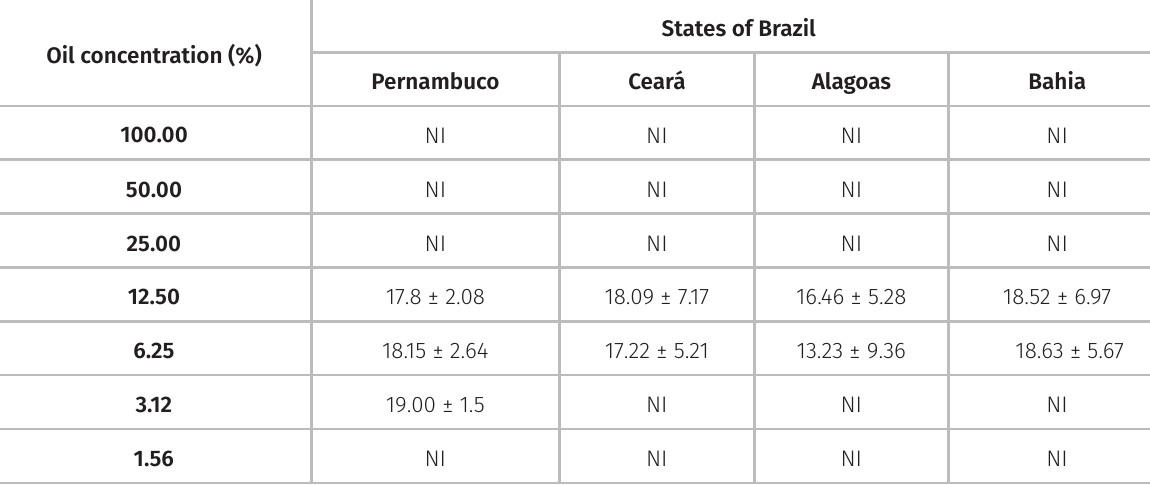
Table II. Inhibition halos of copaiba natural oil ( Copaifera multijuga Hayne) against bubaline mastitis isolates - well diffusion technique.